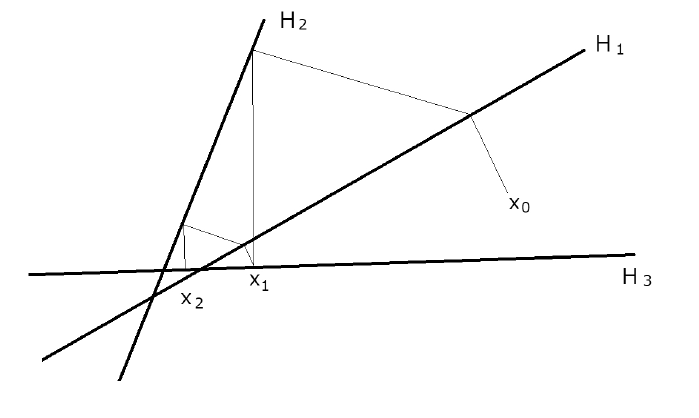
Figure 2. Image of algebraic reconstruction technique